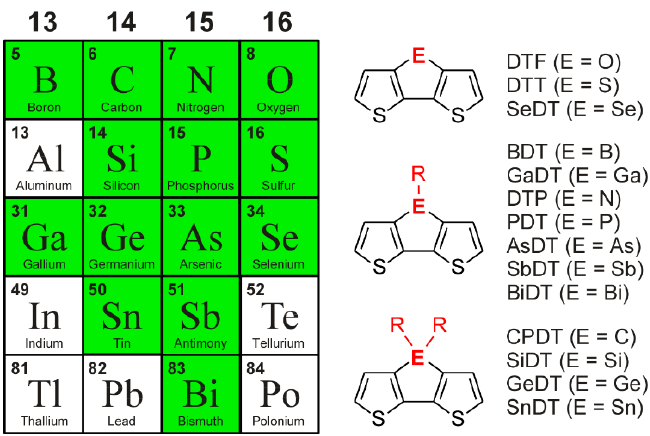
Figure 1. Tricyclic-fused analogues of 2,2’-bithiophene.